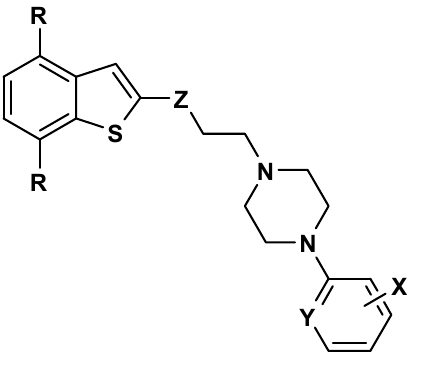
Figure 2. Series of benzo[ b ]thiophene compounds synthesized in this